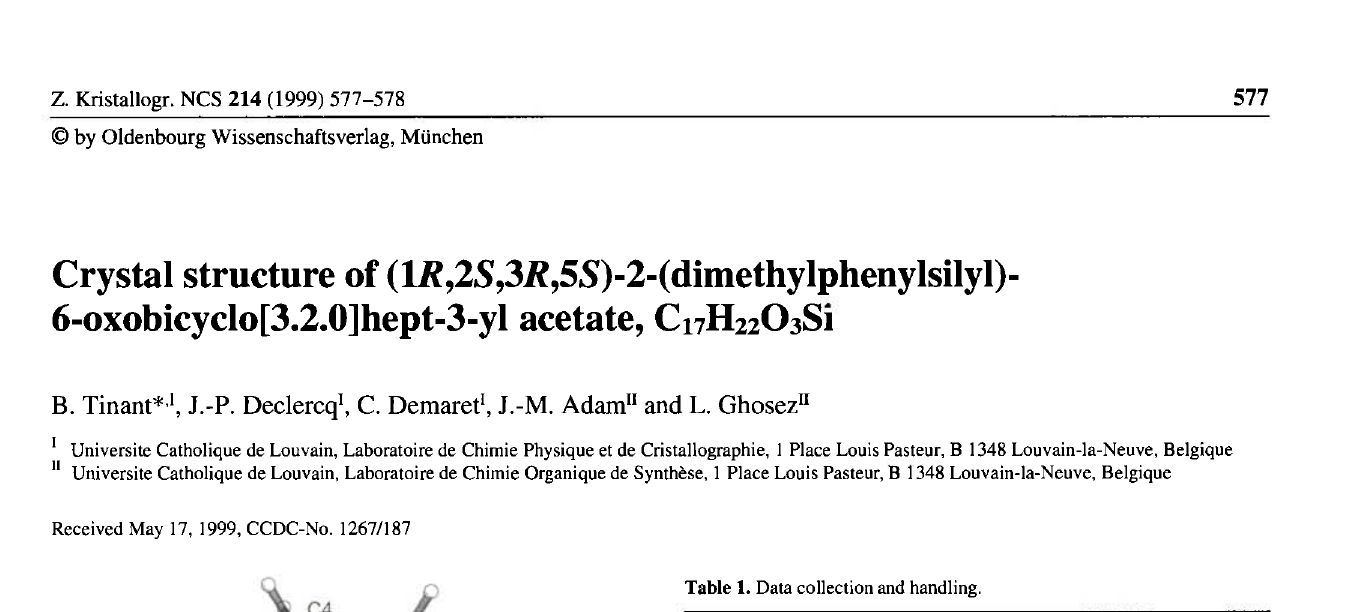
Table 2. Atomic coordinates and displacement parameters (in A